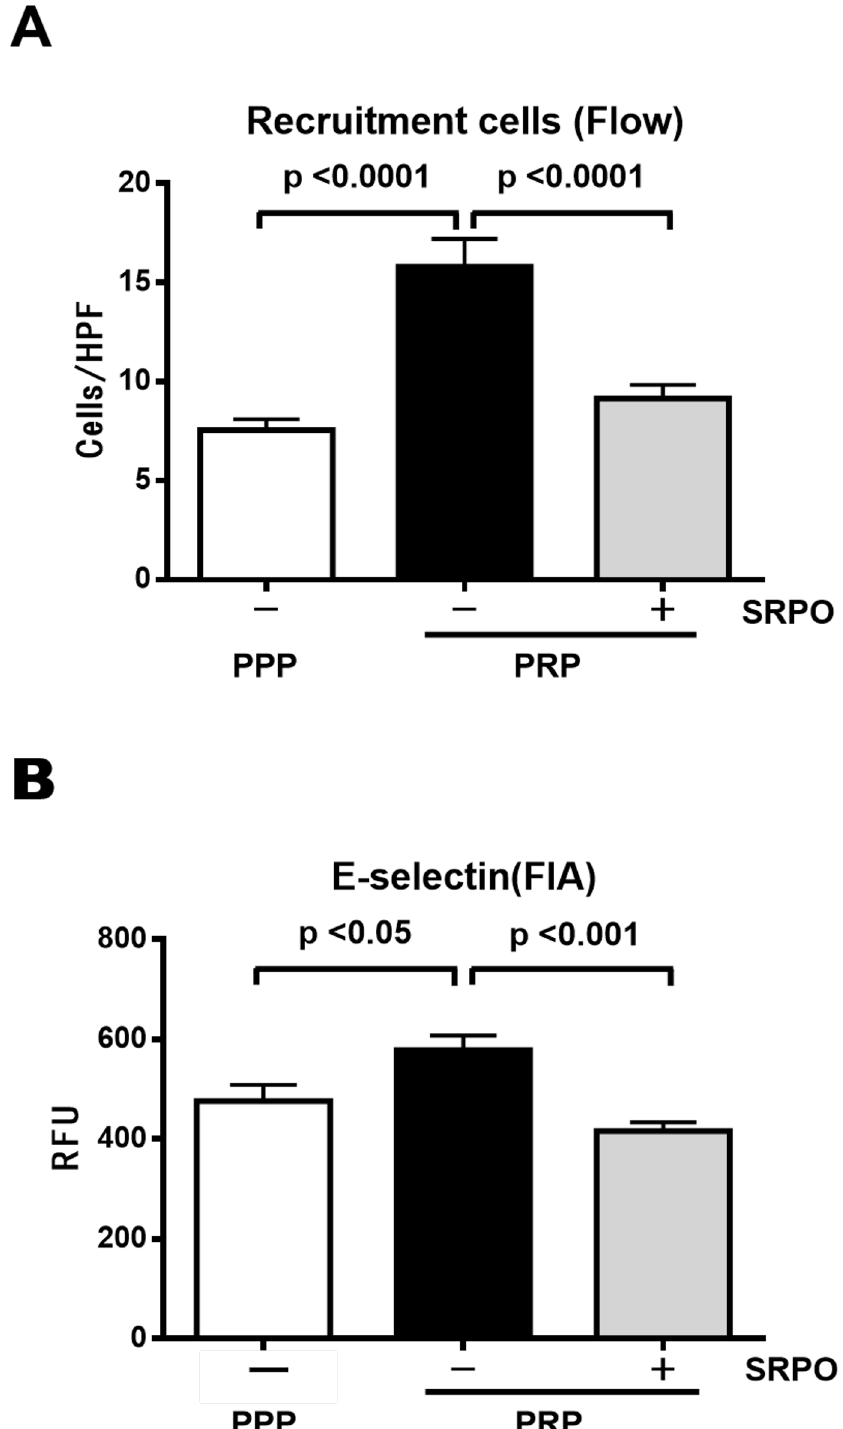
Fig 3. THP-1 cell adhesion to HUVECs (Flow chamber assay) and expression of E-selectin in HUVECs. (A) SRPO significantly reduced the number of PRP-induced THP-1 cell that adhered to HUVECs. HUVEC monolayers were stimulated with 3 ng/ml TNF- α for 3.5 h and exposed to PPP or PRP for 20 min. PRP was pretreated or not with SRPO (10 μ M) just before addition to the HUVECs. THP-1 cells were perfused over activated HUVEC monolayers at a flow rate of 1.0 dyne/cm 2 . Adhesion assays were performed as